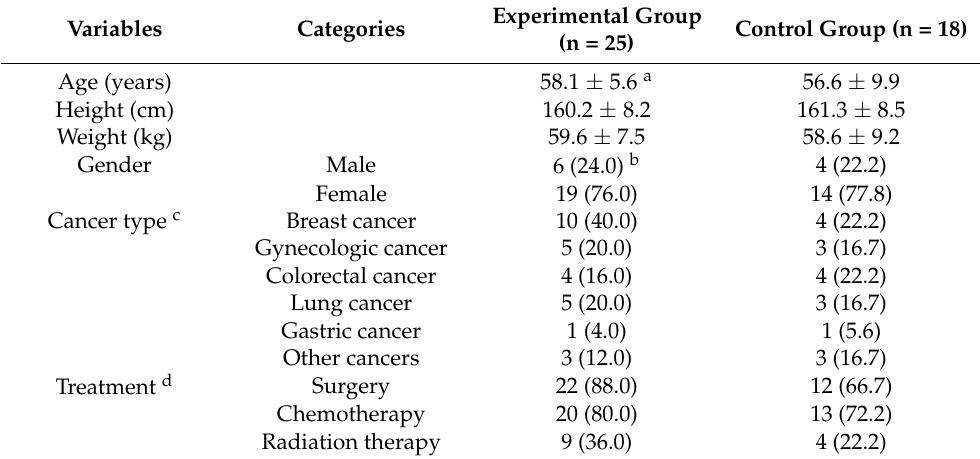
Table 1. Demographic and clinical characteristics of participants (N = 43).